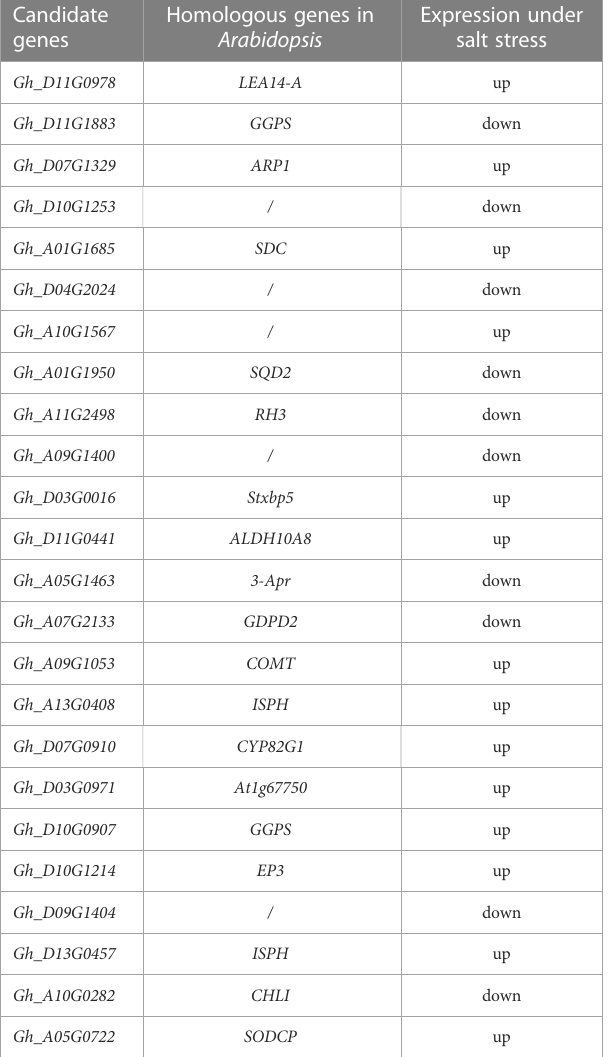
TABLE 1 Candidate gene names and their expression pro fi